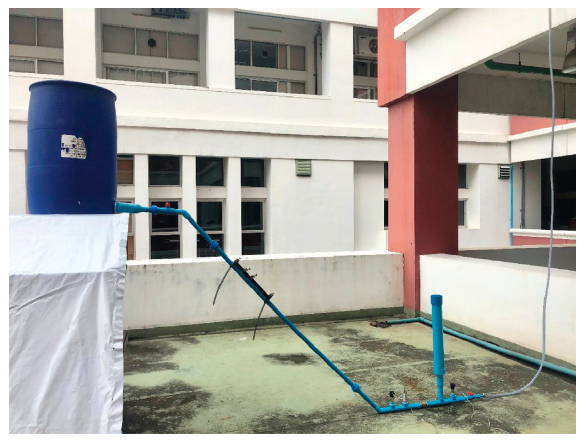
Figure 2: HRP test rig Table 1: Measuring devices specifications.